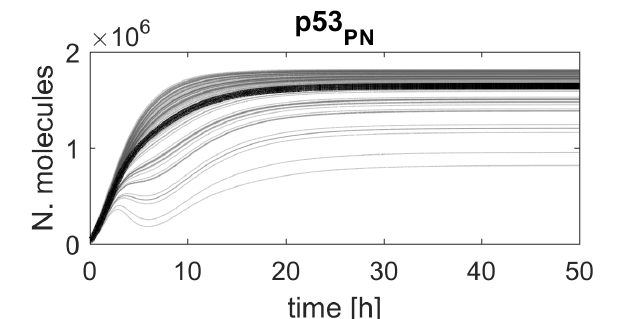
Figure 4. Simulated p53 protein responses in the model with parameter t 0 altered by the reduction factor α . The figure shows 100 randomly selected p53 protein responses (gray lines) and average p53 protein responses (black line) calculated from 1000